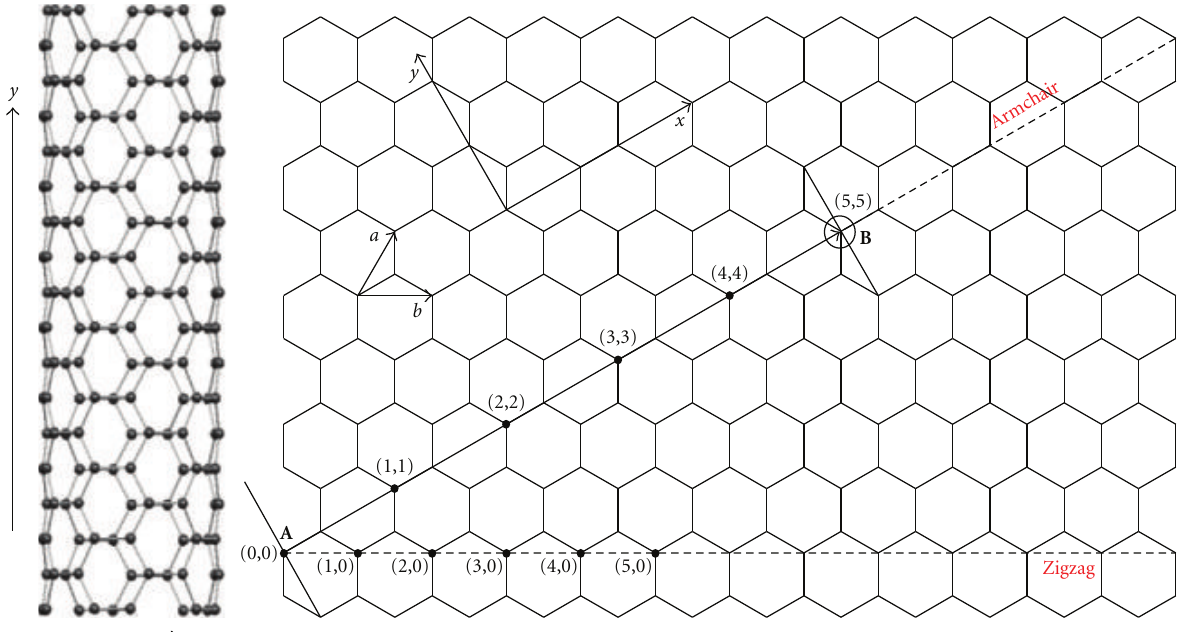
Figure 1: A schematic illustrating the wrapping of a graphene sheet to form a SWCNT. The (5,5) SWCNT is shown on the left [35].